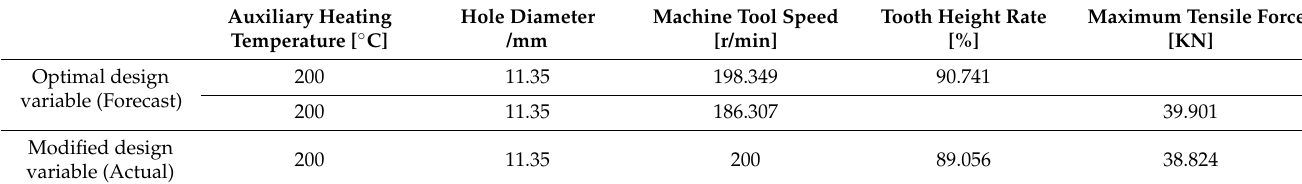
Table 6. Values of optimal design variables andprediction